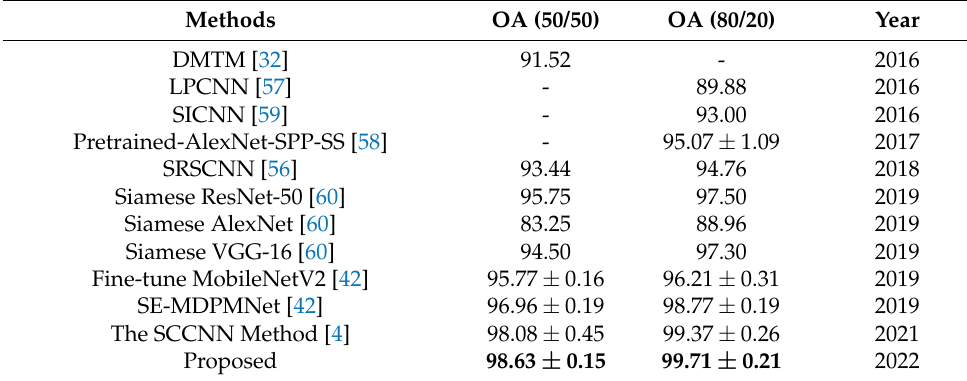
Table 7. OA comparison on SIRI-WHU